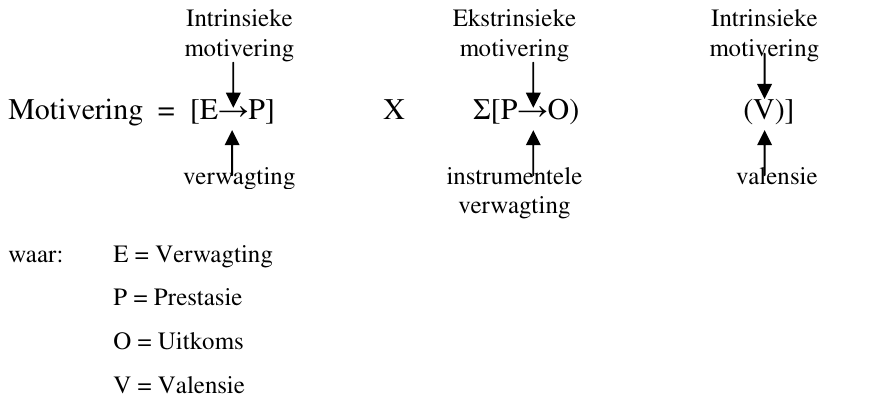
Figuur 4: Intrinsieke en Ekstrinsieke motivering binne die